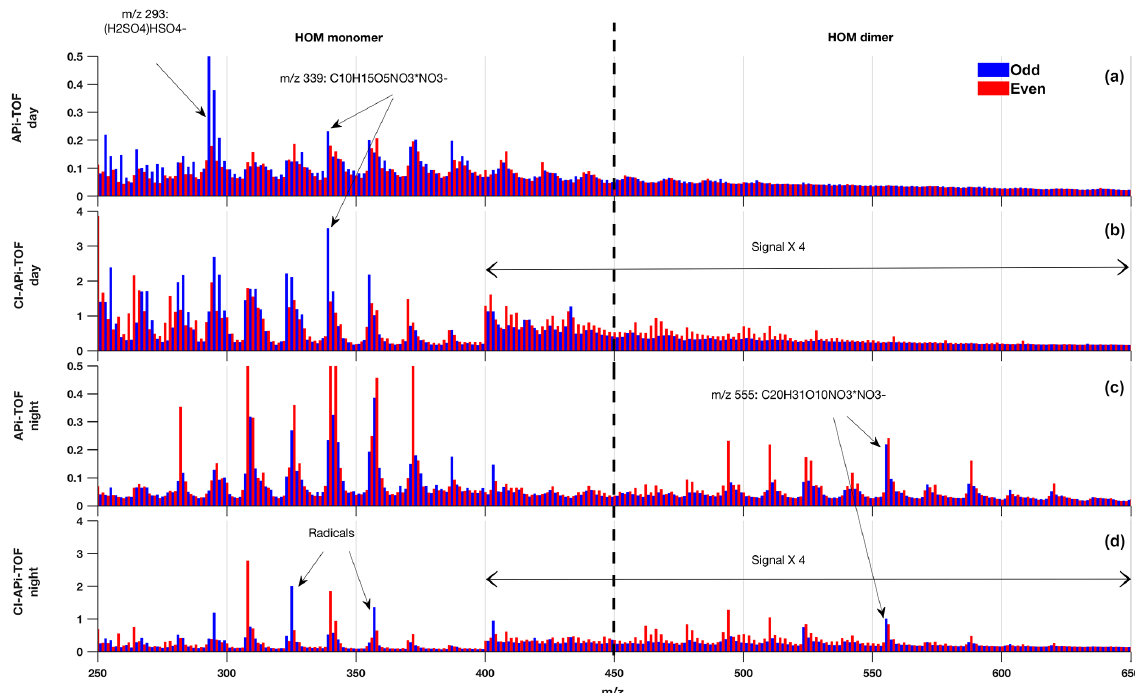
Figure 1. Averaged mass spectra of 10 days (clear sky conditions) of measurements during April and May 2013. The y axes represent the peak intensity in counts per second. Note that the intensities of the measured ions (APi-TOF) are an order of magnitude lower than the one detected after being ionised in the CI unit. Panels (a, b) show respectively negative ions (APi-TOF) and neutral clusters (CI-APi-TOF) during the day (09:00–13:00LT). Panels (c, d) show respectively negative and neutral clusters during the night (23:00–03:00LT). Odd masses have been colour coded in blue and even masses in red. The two black arrows in (b) and (d) show the area of the spectrum where the signal has been multiplied by 4 (done only for the